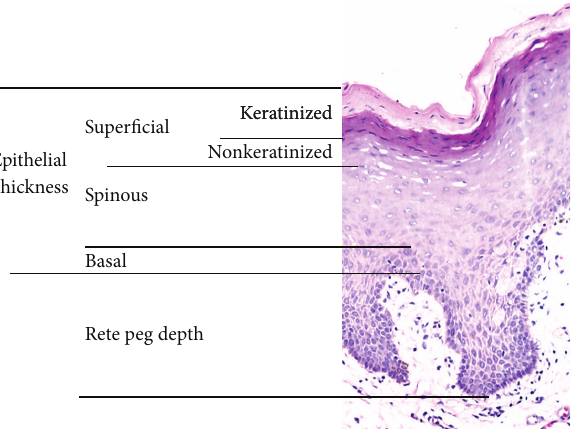
Figure 1: Histological preparation of one of the study samples at 200-fold magnification under light microscopy showing how the epithelium was divided into four main components for histomor- phometric analysis. Thickness of the various sections was deter- mined by drawing arbitrary lines running vertically and reading off the length/depth as was indicated by the